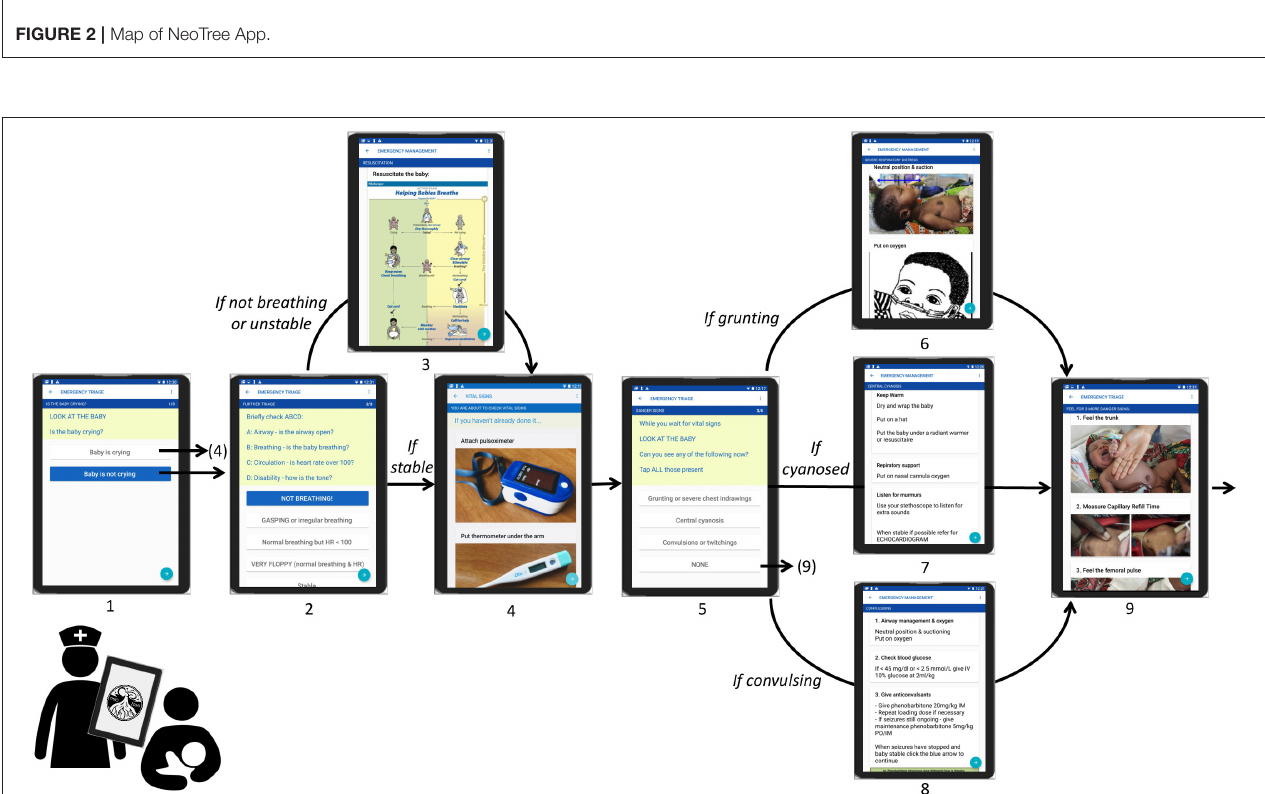
FIGURE 3 | Example NeoTree screen flow (Screens 1–9; emergency triage and vital signs).